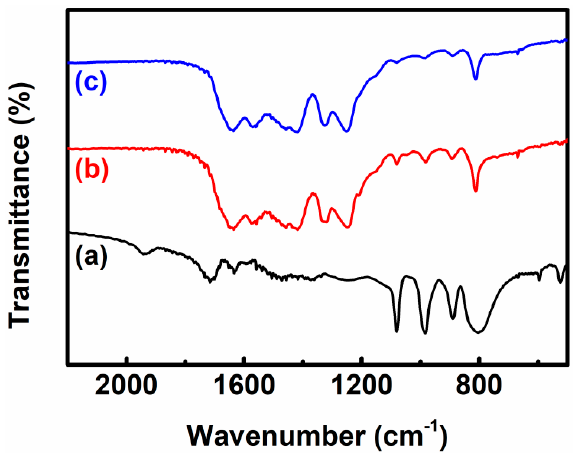
Figure 3. FTIR spectra of the as-synthesized samples: (a) PW 9 ; (b) PW 9 /g-C 3 N 4 heterojunction NSs; (c) g-C 3 N 4 NSs.